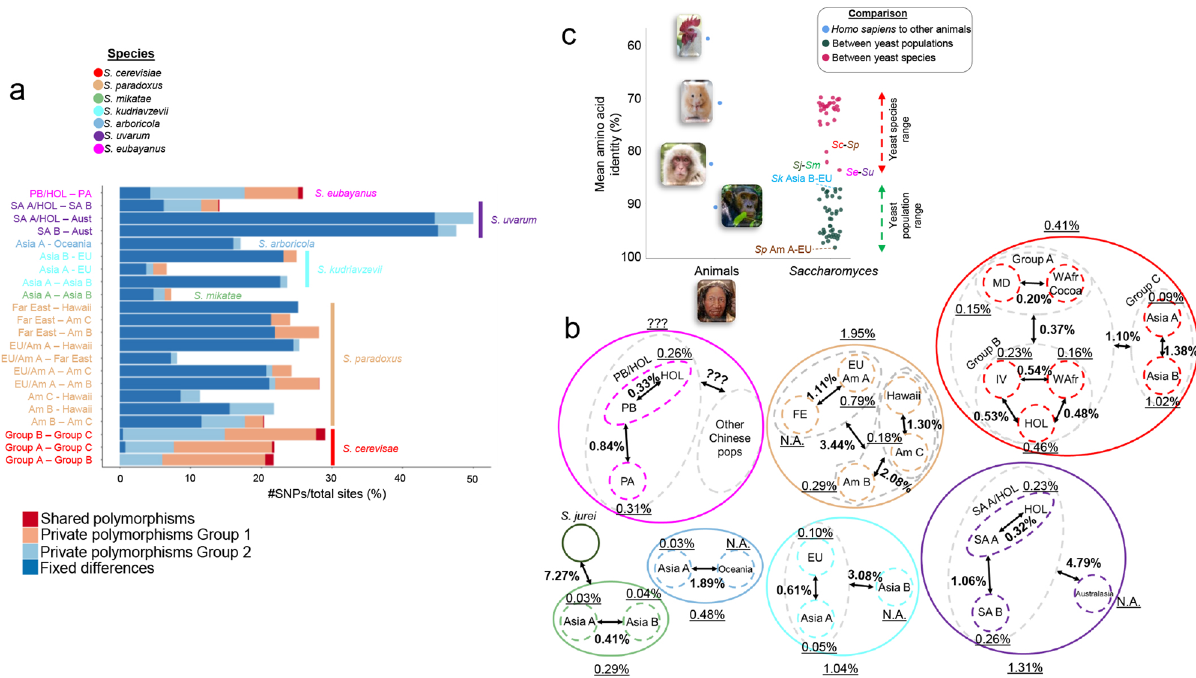
Fig.3|Speciesandpopulation-leveldiversityin Saccharomyces .a